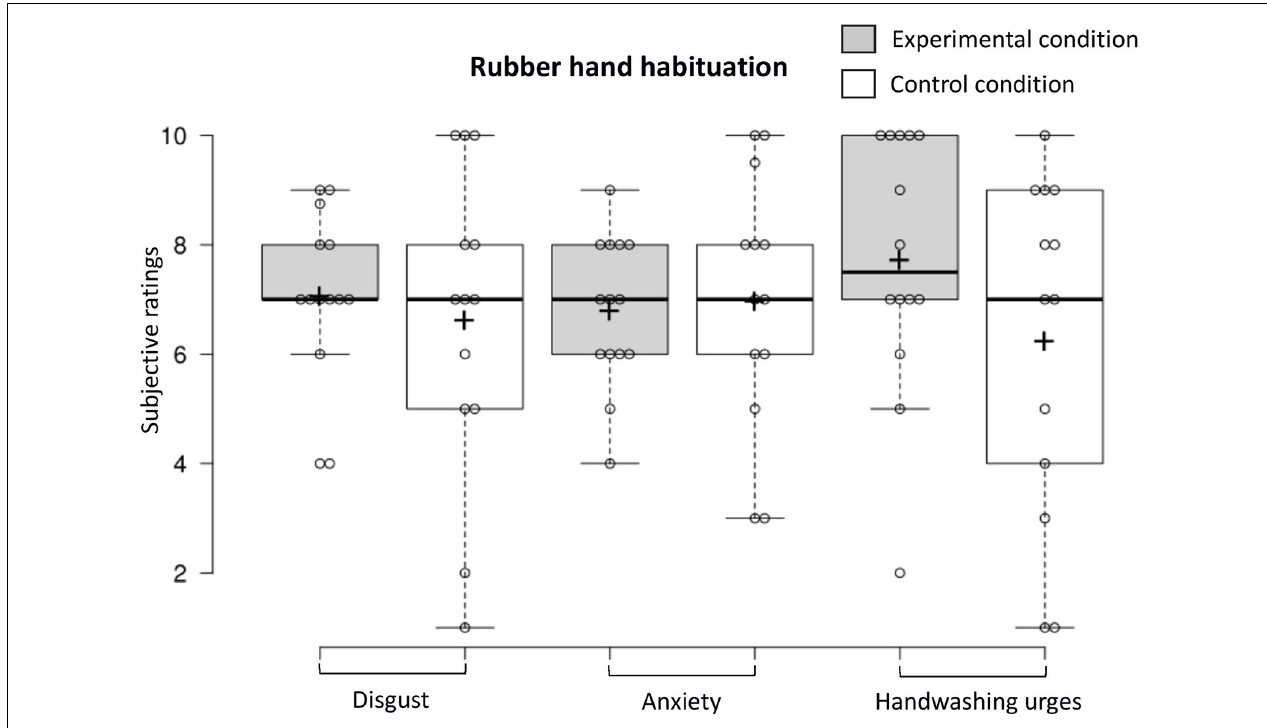
FIGURE 7 | Contamination sensations ratings in the experimental and control condition during the rubber hand habituation